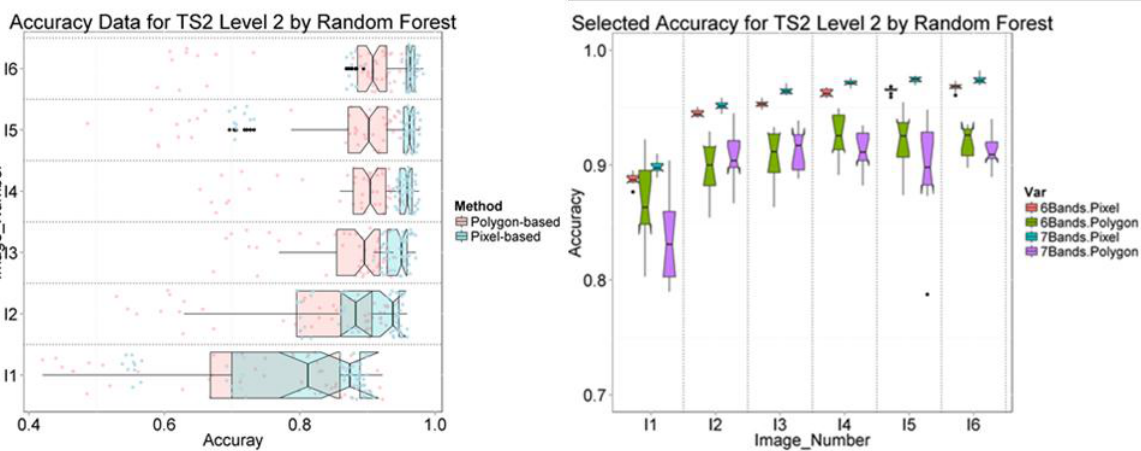
Figure 1. The distribution of OA values for the Level 1 land cover category classification using times series TS1, the polygon-based and pixel-based 10-fold cross validation methods and the Random Forest methods. ( Left ): all variants (Table 2) are summarized in a single box-plot; ( Right ): OA comparison of selected variants of 6Bands without thermal band and 7Bands with thermal band.